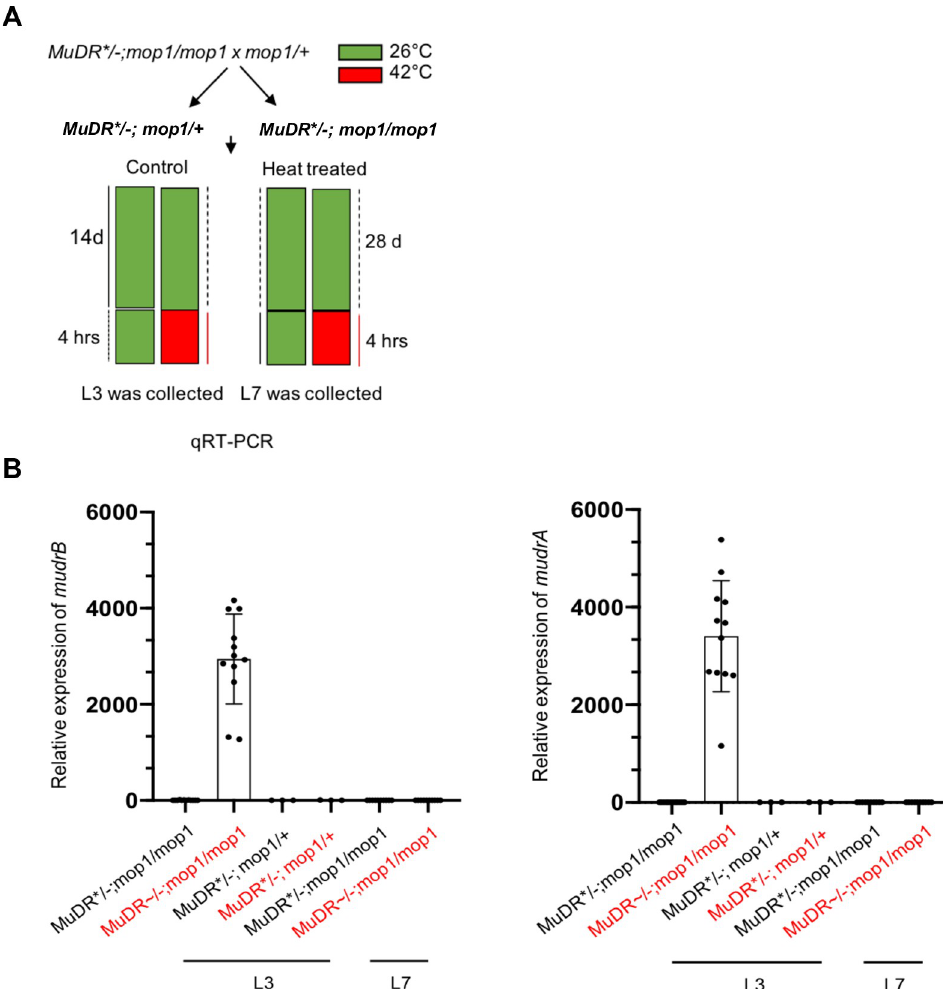
Fig 3. Expression of mudrA and mudrB in plants under heat stress. (A) Schematic diagram of the heat-reactivation experiment. (B) qRT-PCR of mudrA and mudrB in leaf 3 and leaf 7 in plants of the indicated genotypes. Twelve biological replicates are used for each experiment. Tub2 is an internal control gene. Additional controls for each experiment include MuDR/- , pooled samples from twelve heated MuDR � /-; mop1/+ plants and twelve unheated plants. Red text is used to indicate samples that were subjected to heat